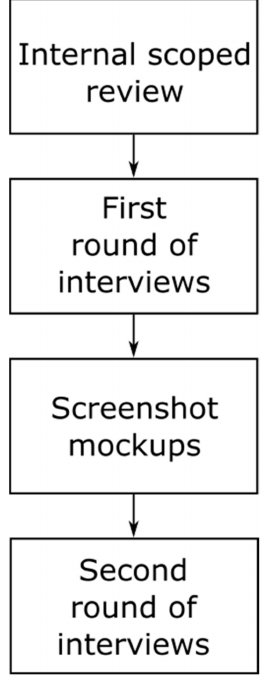
Figure 1. Outline of the process of requirements